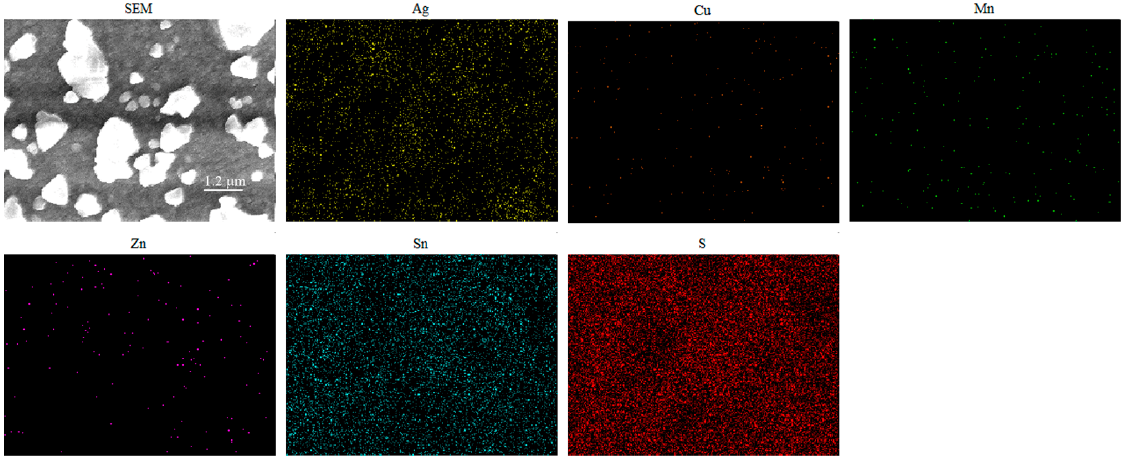
Figure 5. EDS mapping results for Ag and Mn co-doped Cu 2 ZnSnS 4 thin film with Ag/(Ag + Cu) = 2/3.